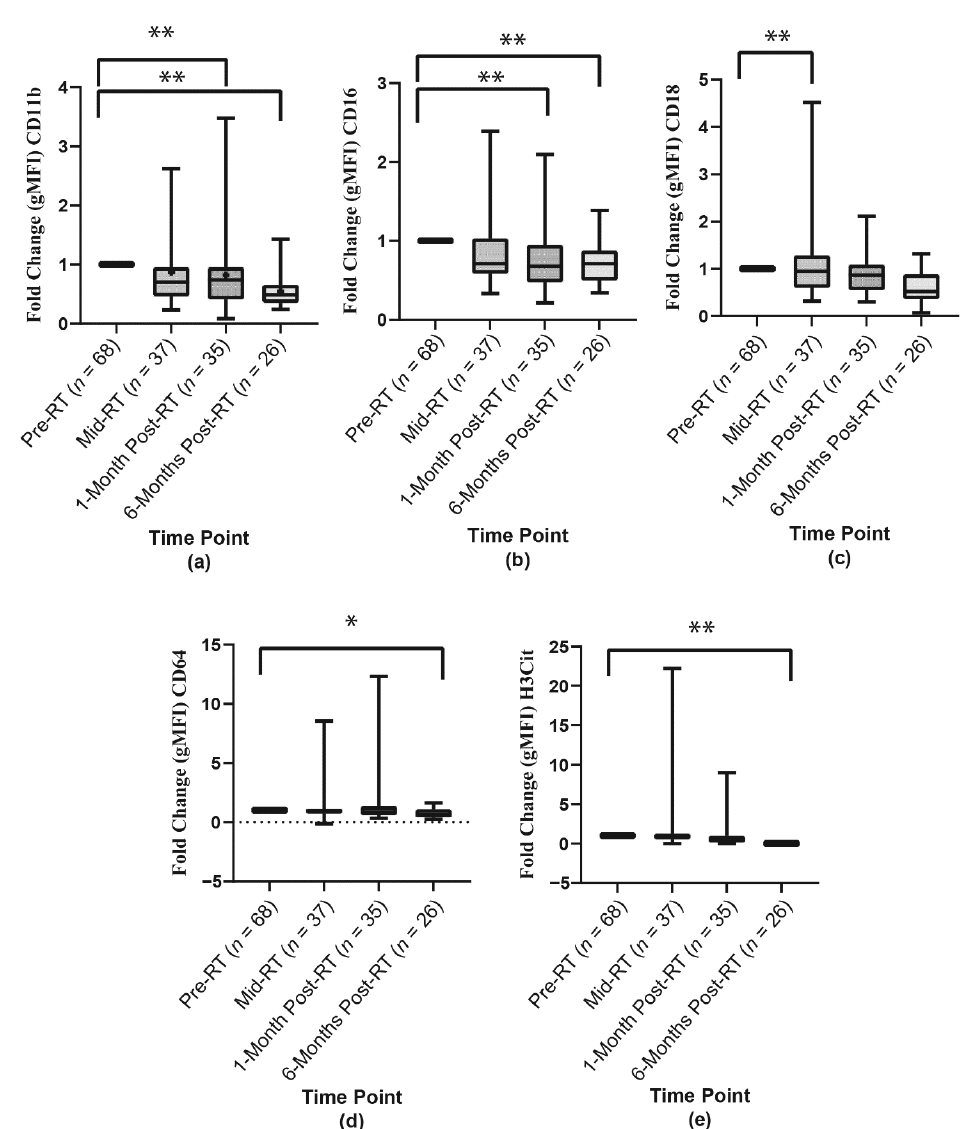
Figure 3. The mean geometric MFI fold-change of the oPMN ( a ) CD11b, ( b ) CD16, ( c ) CD18, ( d ) CD64, and ( e ) H3Cit markers across the four-time points. (+) The mean fold change. (*) Statistically significant mean difference p < 0.05. (**) Statistically significant mean difference p < 0.005.